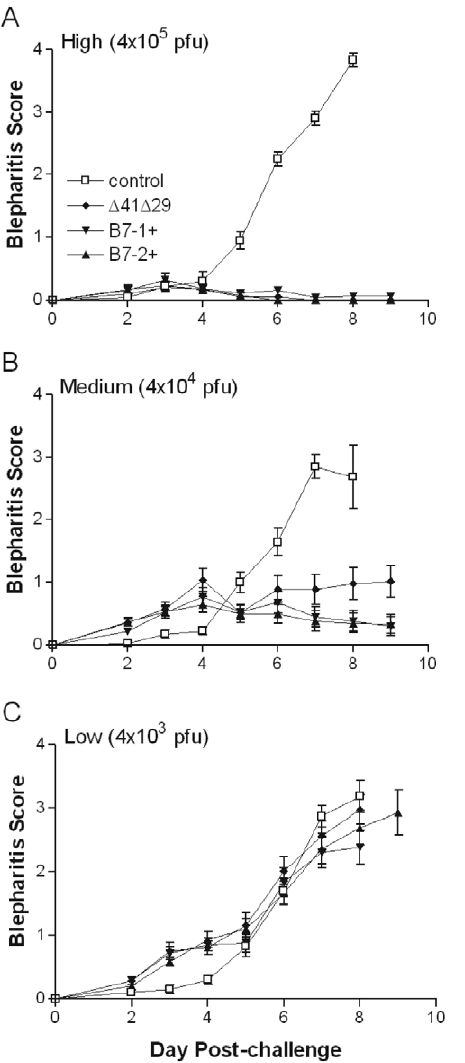
Figure 6. Incidence of keratitis. Eyes of mice were scored in masked fashion for signs of keratitis 9 d and 14 d post-challenge. Mean scores are shown for groups immunized with the A) high, B) medium, or C) low doses of the indicated virus or control supernatant. Data represent the mean 6 SEM for all mice surviving on the indicated day and were compiled from 2 independent experiments (total=22 to 24 eyes for each high dose group on days 9 and 14; 28 to 30 eyes for each medium dose group on days 9 and 14; 20 to 26 eyes for each low dose group on day 9 and 14 to 16 eyes for each low dose group on day 14). **, P , 0.001; *, P=0.01 for D 41 D 29 compared with D 41 D 29B7-1 and D 41 D 29B7-2.